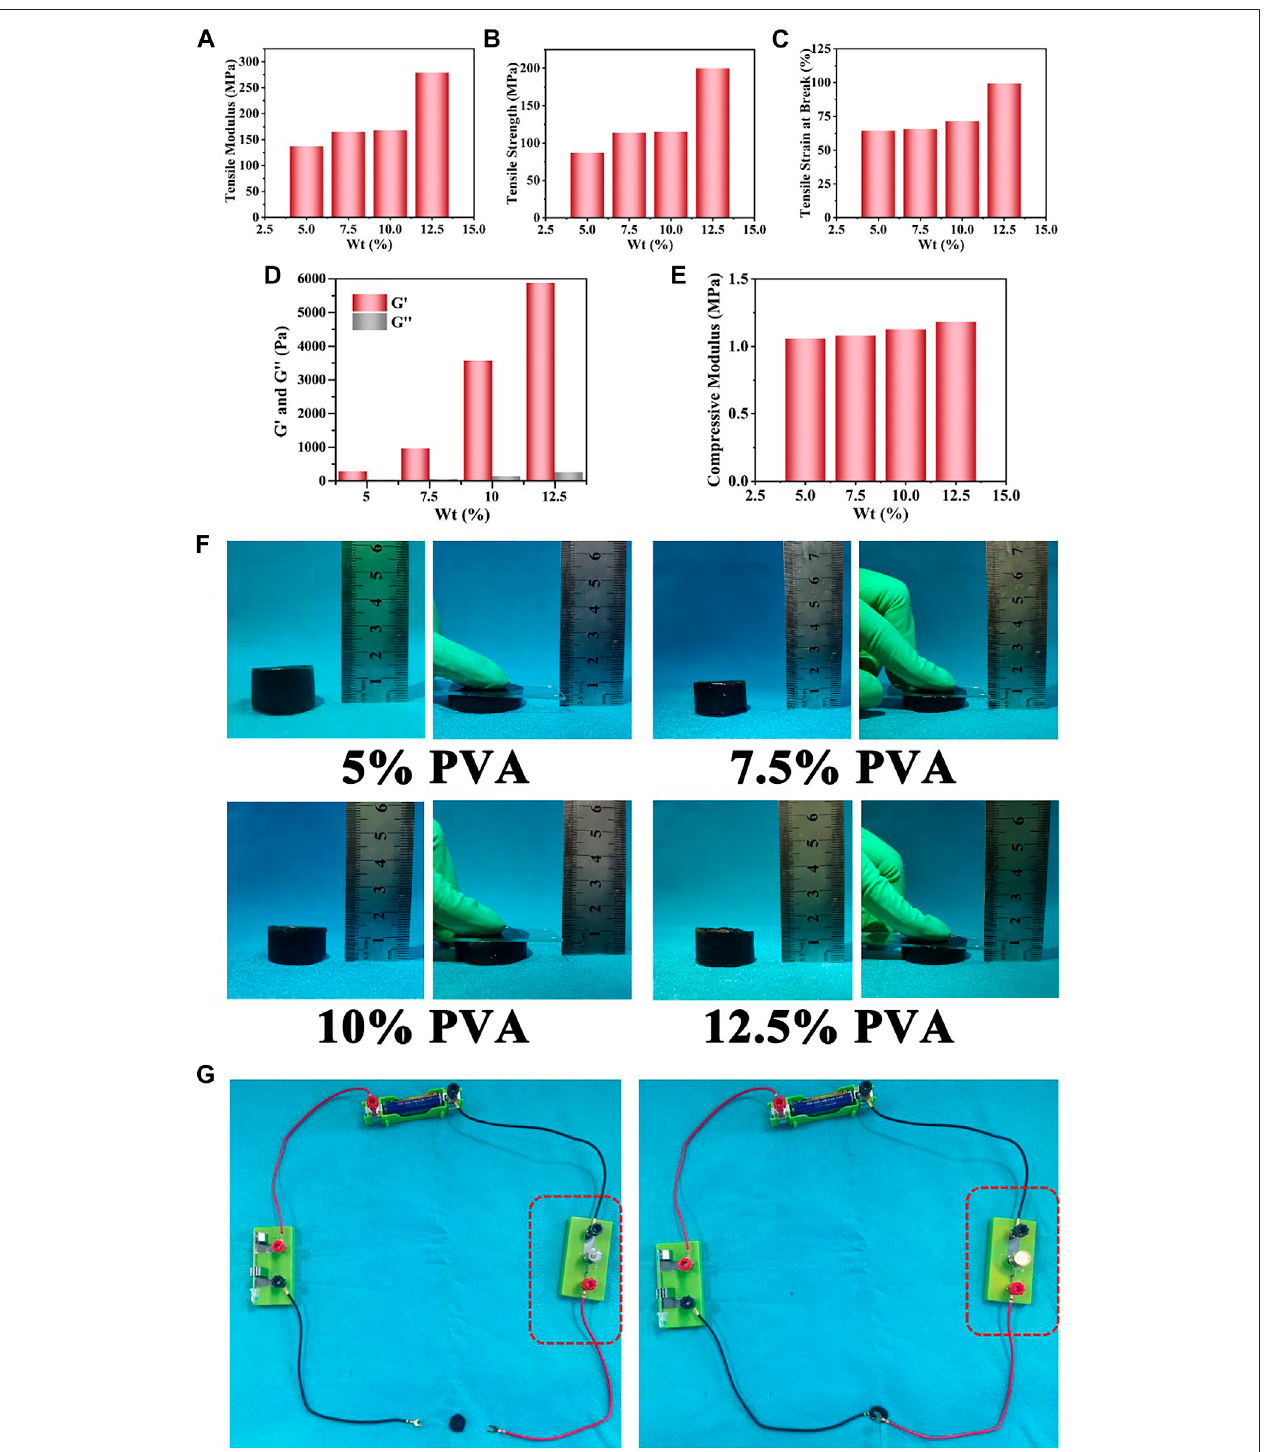
FIGURE 1 | The tensile and compression performance tests of the Ag NPs/CPH material prepared with different amounts of reactive PVA content (5, 7.5, 10, and 12.5 wt%): (A) tensilemodulusofelasticity. (B) Tensilestrength. (C) Tensilestrainatbreakage. (D) Thestorage(G ′ )andloss(G ″ )modulus. (E) Compressivemodulus. (F) Thephotos ofcompressive deformationeffectofpreparedPVP@AgNPs/CPHwithdifferentPVAconcentrationsunderacertain pressure. (G) ConductiveAgNPs/CPH (with AN reactive volume of 600 μ L) connected to a circuit, which made the bulb glow.